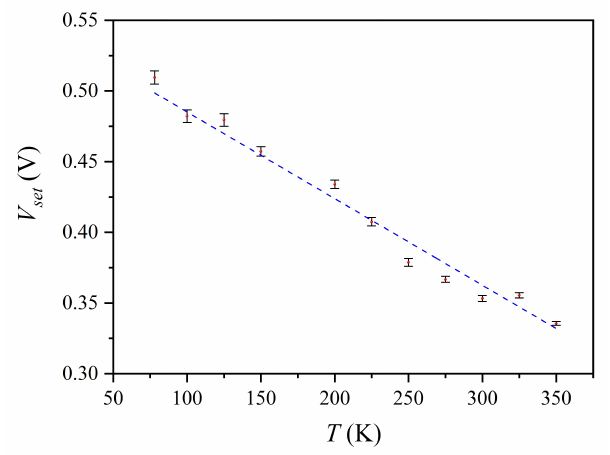
Figure 7. Set voltage, V set , mean value of 100 I–V